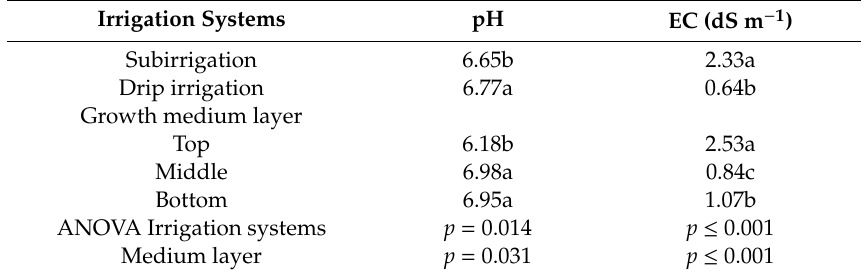
Table 2. Growing medium pH and electrical conductivity (EC) at experiment termination as affected by two irrigation systems and the root ball substrate layer of tomato ( Solanum lycopersicum L.) plants.